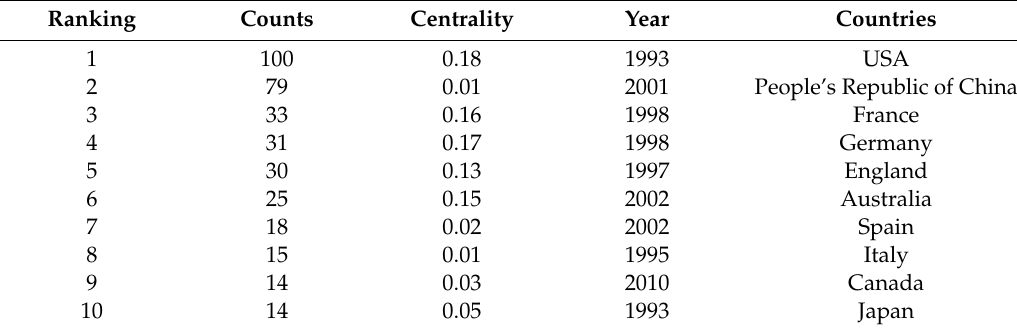
Table 1. Top 10 most productive countries regarding big ocean data documents.